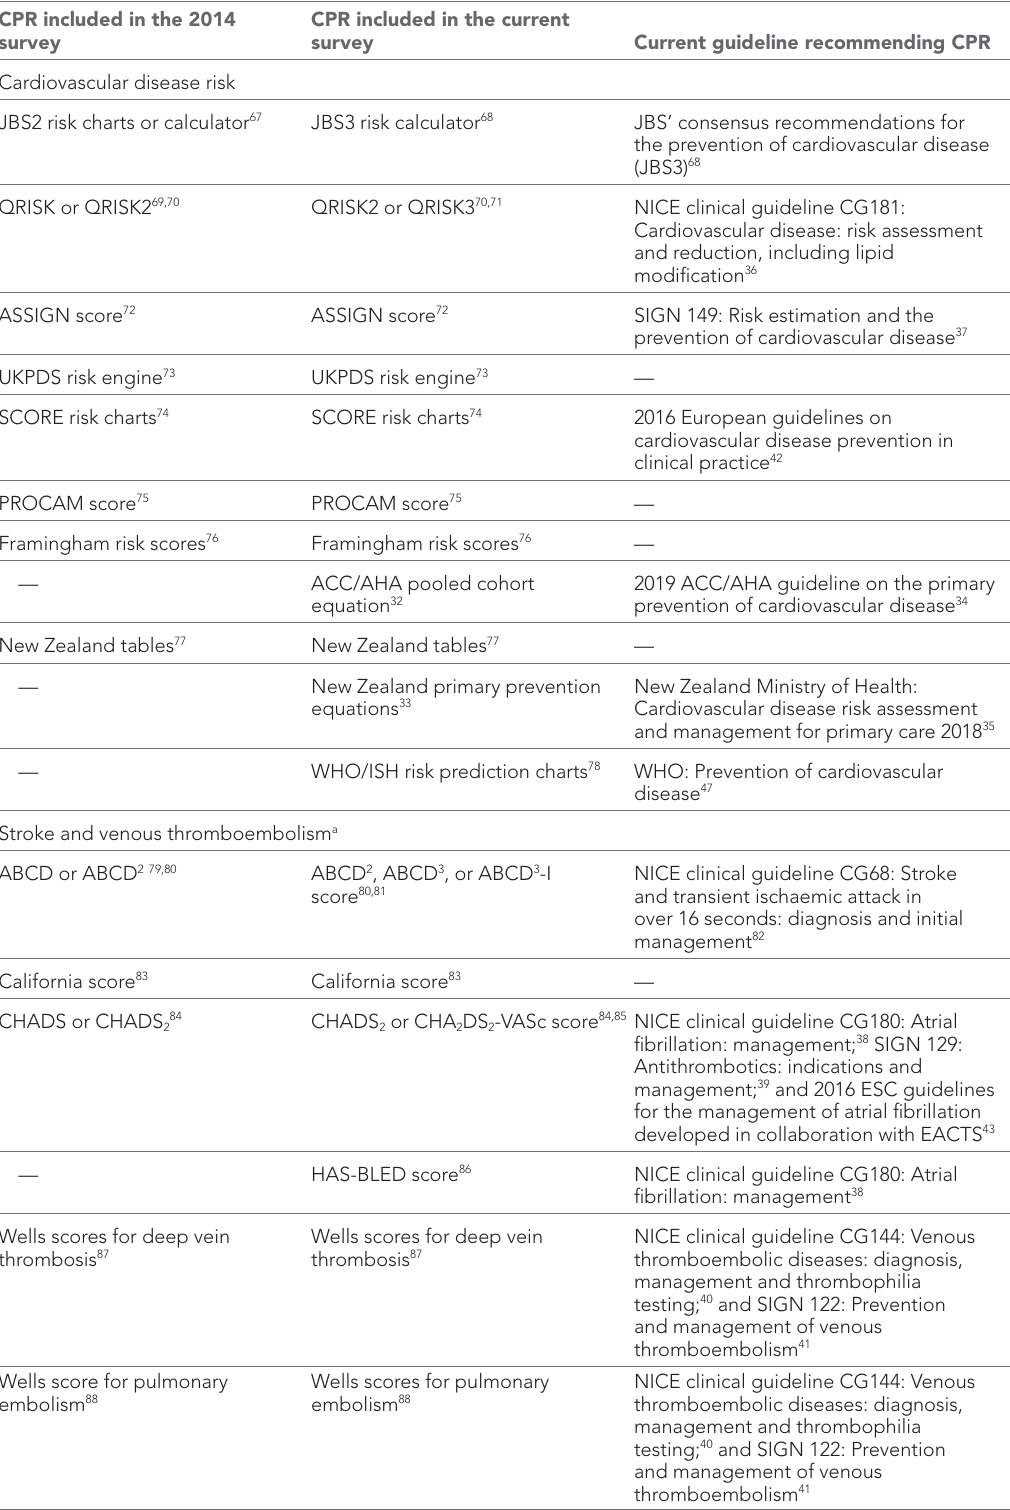
Table 1 Clinical prediction rules included in the current and 2014 survey CPR included in the 2014